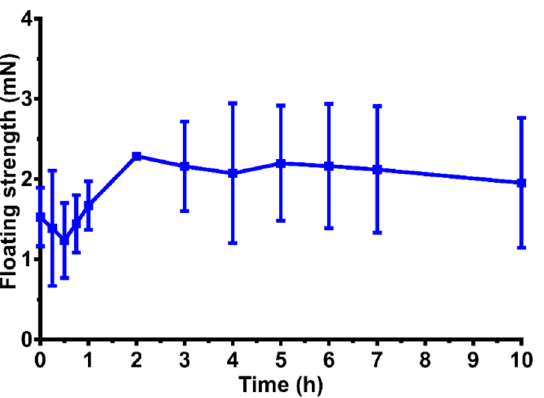
Figure 10. Floating behavior of formulation V2 in a buffer of pH 1.2 at 37 ± 0.5 °C. The mean ± S.D. are presented (n = 3).